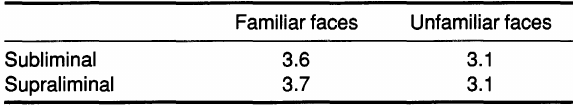
TABLE I. Peak amplitude EDA (in "",S) for familiar and unfamiliar faces presented above (supraliminal) and below (subliminal)